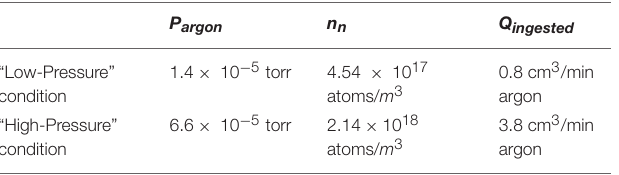
TABLE 1 | Neutral argon number density and volumetric flow rate values for the “Low-Pressure” condition and the “High-Pressure” condition.